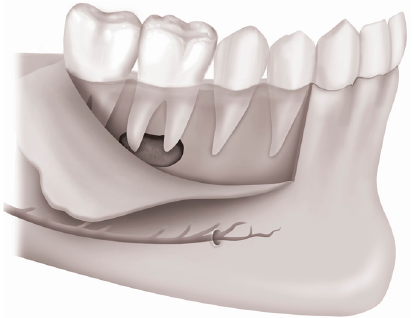
Figure 10. Vertical incision for endodontic microsurgery of the mandibular first molar. Note that the vertical incision was placed on the mesial line angle of the mandibular first premolar and parallel to the root longitudinally. This helps to avoid mental nerve injury and the scar on the gingival tissue.